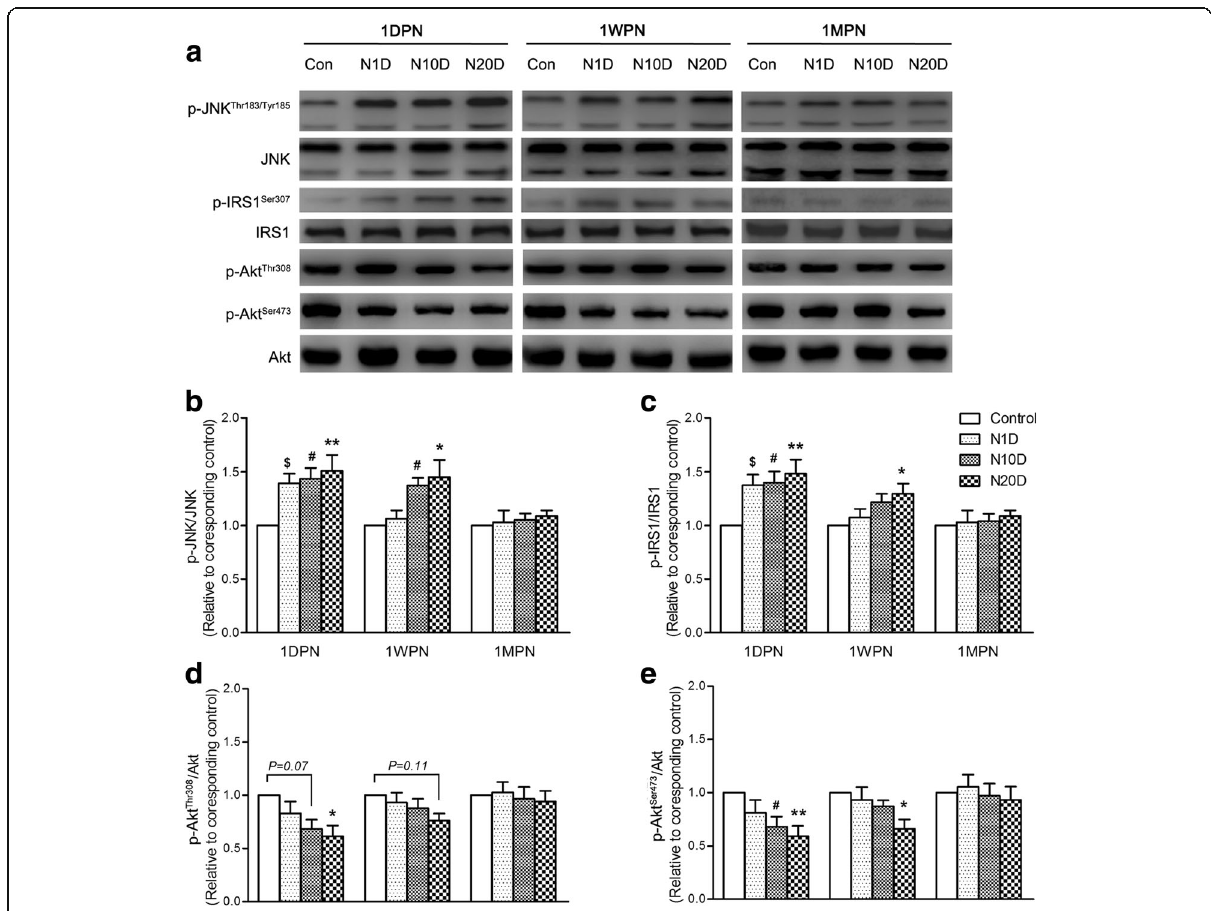
Fig. 3 Effect of noise exposure on insulin signaling pathways in the gastrocnemius muscle. a Levels of total and Thr 183 /Tyr 185 phosphorylated JNK, total and Ser 307 phosphorylated IRS1, and total Akt and phosphorylated Akt at Ser 473 and Thr 308 were detected via immunoblotting, and representative Western blots are presented. b – e Graphs showing the relative intensities of phospho-protein bands are normalized to the corresponding total protein levels in each case. The data are expressed relative to values for age-matched controls. The average of each age-matched control group was set to 1. Values are presented as the mean±SEM of 8 mice per group. * p <0.05 and ** p <0.01 indicate significantly different mean values in the post hoc comparisons between N20D and the control after a one-way ANOVA, demonstrating a significant effect of noise. # p <0.05 indicates N10D vs control group. $ p <0.05 indicates N1D vs